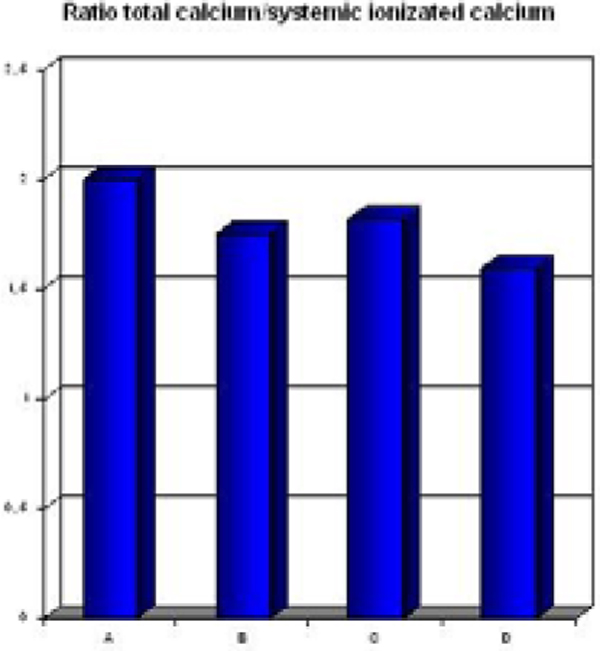
Ca2+/iCa2+ ratio for each patient to verify the nontoxicity of the citrate and the end of CPFA.